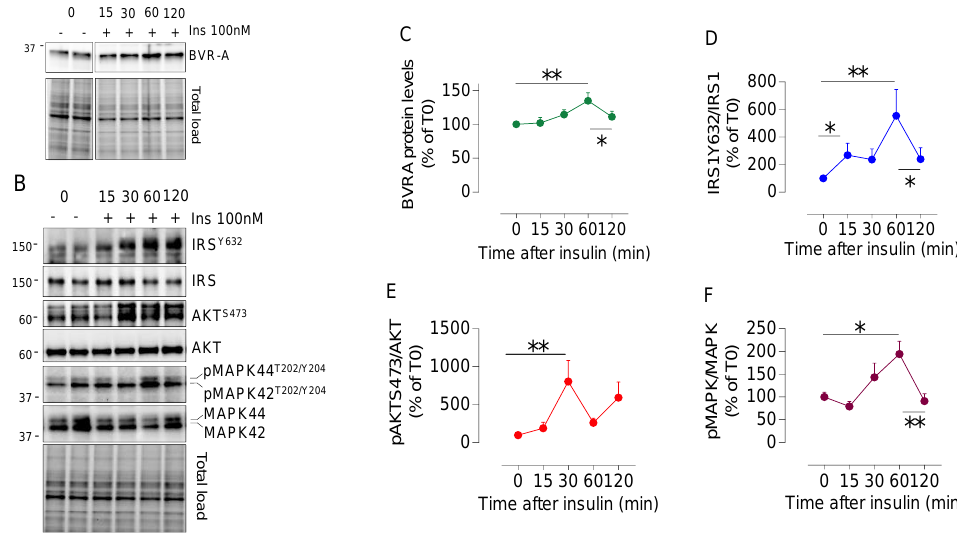
Figure 4. BVRA protein levels along with the activation of main proteins of the insulin signaling pathway were evaluated in HEK293 cells treated with 100 nM insulin for 15, 30, 60, and 120 min. ( A , B ) Representative Western blot and total load images and densitometric evaluation of ( C ) BVRA protein levels; ( D ) IRS1 activation evaluated as a ratio between the IRS1 active form (IRS1Y632) and the IRS1 total protein levels (pIRS1Y632/IRS1); ( E ) AKT activation evaluated as a ratio between the AKT active form (AKTS473) and the AKT total protein levels (pAKTS473/AKT); and ( F ) MAPK activation evaluated as a ratio between the MAPK active forms (pMAPK42/44 T202/Y204) and the MAPK total protein levels (pMAPK/MAPK). Data are shown as mean ± SEM ( n = 4 – 5 independent cultures/group) One-way ANOVA with Bonferroni post hoc test: * p < 0.05, ** p < 0.01.